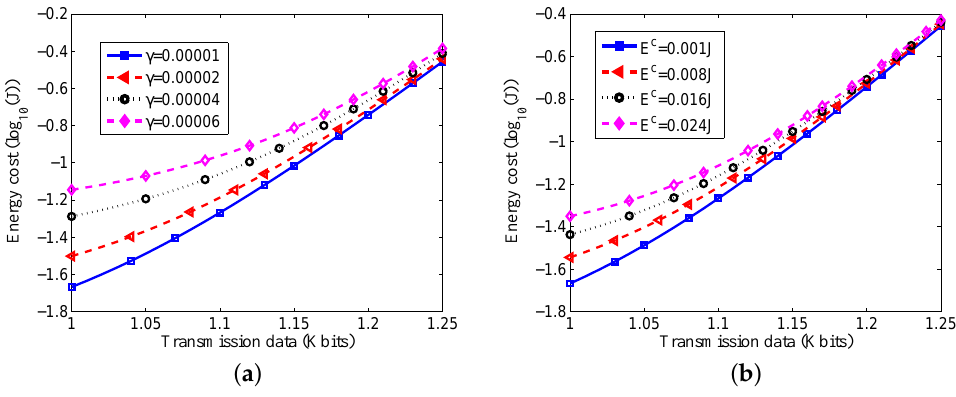
Figure 3. ( a ) Effects of transmission data size ω on energy consumption under different γ ; ( b ) Effects of transmission data size ω on energy consumption under different E c .